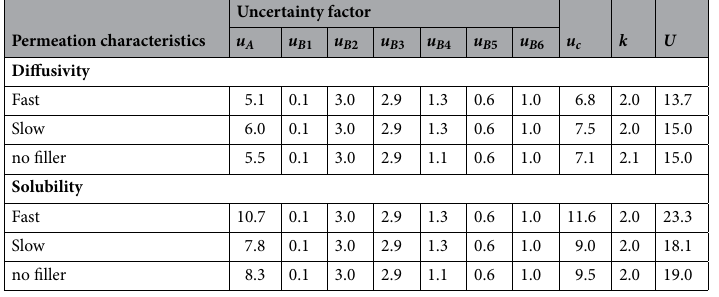
(Fig. 8a, right] using one diffusivity with a single term of Eq. (1) consistent with the experimental data, which corresponds to the fast diffusion coefficient in NBR with CB filler. Therefore, in NBR with CB, the component with a fast diffusion coefficient [C R H (polymer)] is due to the H 2 absorbed in the main macromolecular polymer network that constitutes the rubber irrespective of CB filler, and the slow component [C R H (filer)] is due to H 2 absorbed in the CB filler. In similarity with NBR, Fig. 8b shows the time dependent content of remaining hydrogen in EPDM speci- mens. Filled circle is measurement result in EPDM with and without CB fillers. In the left part of Fig. 8b, black line is simulated sum of blue dotted line and red dotted line, which are two simulation contributions by two Eq. (1). The blue dotted line is explained as the fast diffusion of the specimen according to the H 2 behavior in the polymer network, whereas red dotted line is the comparatively slow diffusion owing to the H 2 trapped in the CB. As presented in left part of Fig. 8b, the permeation property of H 2 in specimen was also explained as coming from two behaviors of H 2 sorbed in rubber network and CB. In specimen without CB, the simulation [black line in right part of Fig. 8b with a diffusion behavior in one term of Eq. (1) are essentially in agreement with the experimental result. However, the results simulated (black solid line) by the program with a diffusion behavior by a single term of Eq. (1), as shown in the FKM of Fig. 8c, were in agreement with the experimental result within standard deviation of 1%. The possibility for one diffusion behavior may be proposed by the following explanation. In the previ- ous measurement of the FKM rubber filled with CB using precise electronic balances, the mass of FKM before and after hydrogen charging was compared with each other. The mass after hydrogen charging was taken at the attainment of equilibrium after hydrogen release from rubber at infinite time. It was found that the mass after hydrogen charging does fully not recovered to the mass before hydrogen charging, in other words, the mass after charging increased by ~ 40 wt∙ppm of mass before charging. This means that the part of penetrated hydrogen gas may remain in specimen and is replaced by interstitials or vacancies. However, the mass of the NBR and EPDM filled with CB before and after hydrogen charging are found to be same, implying most adsorbed hydrogen into rubber was desorbed from it.